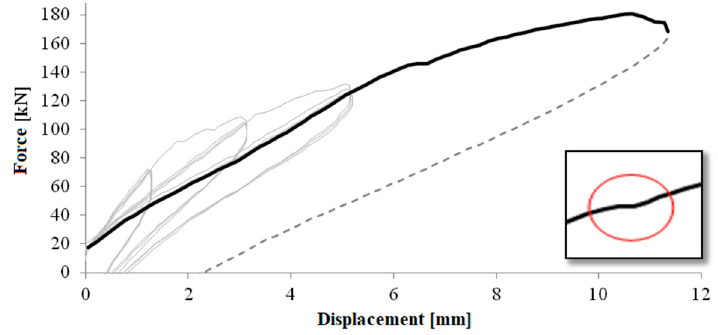
Figure 19. Load-displacement diagram at fourth drift (positive values)—rectangular pier.